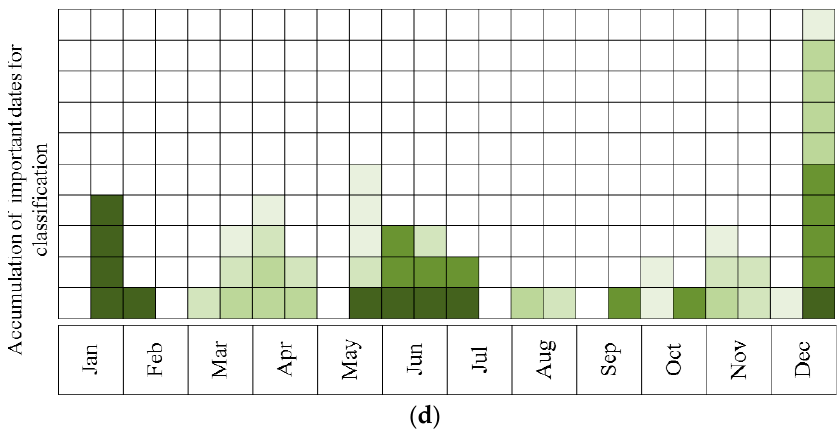
Figure 9. The five most important dates for classification in all four near-surface sites—results of ten sequential runs. The classification was carried out by RF classifier, using all spectral indices. Each colored block represents an important date for classification, selected in one of the ten sequential runs, and each column represents the accumulation of these dates during a half-month period. Optimal dates for species classification, by order of contribution for improving the overall classification, within each of the ten runs: ( a ) Sataf southern-facing site (S ′ S), 708 individuals, 11 species; ( b ) Sataf northern-facing site (S ′ N), 279 individuals, ten species; ( c ) Mata site (M), 551 individuals, 11 species; ( d ) Britanya site (B), 314 individuals, nine species.